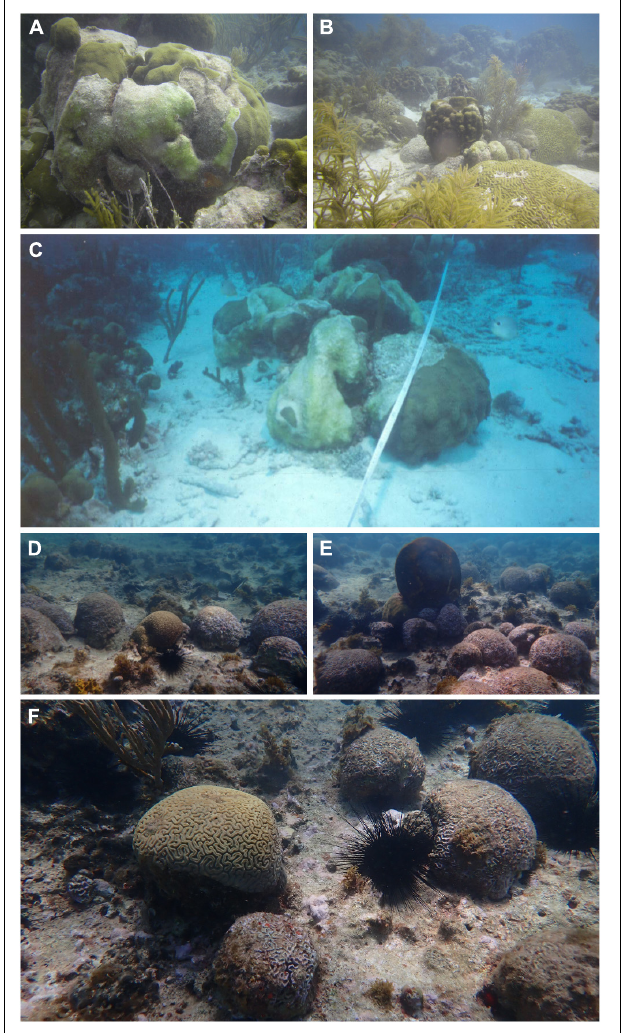
FIGURE 5 | Examples of devastating effects of WPD-II and SCTLD on coral communities after epizootic events. (A) Active WPD-II multifocal infection on Orbicella faveolata and recent mortality during an epizootic event along the eastern barrier of Los Roques in 2009. (B) Arrows pointing dead colonies of Orbicella annularis and Pseudodiploria strigosa at the eastern barrier of Los Roques during a WPD-II epizootic event. (C) Orbicella annularis colony showing active WPD-II lesion during an epizootic event in Madrizqui, Los Roques in 2002. This event significantly reduced live coral cover in this site. (D–F) SCTLD mortality recorded at Piedra Miguelito (Sosua), Dominican Republic. The disease was first reported in 2020 and photos were taken in April 2021. Photos A.